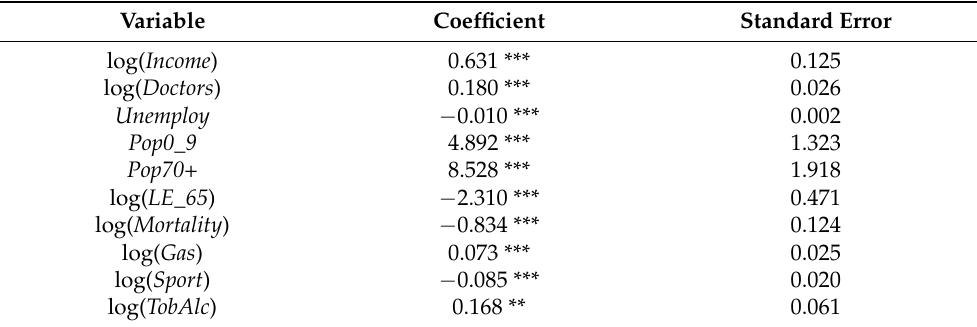
Table 3. Estimates of panel-data regression model 1 describing determinants of real out-of-pocket health expenditure 2 in Polish regions in years